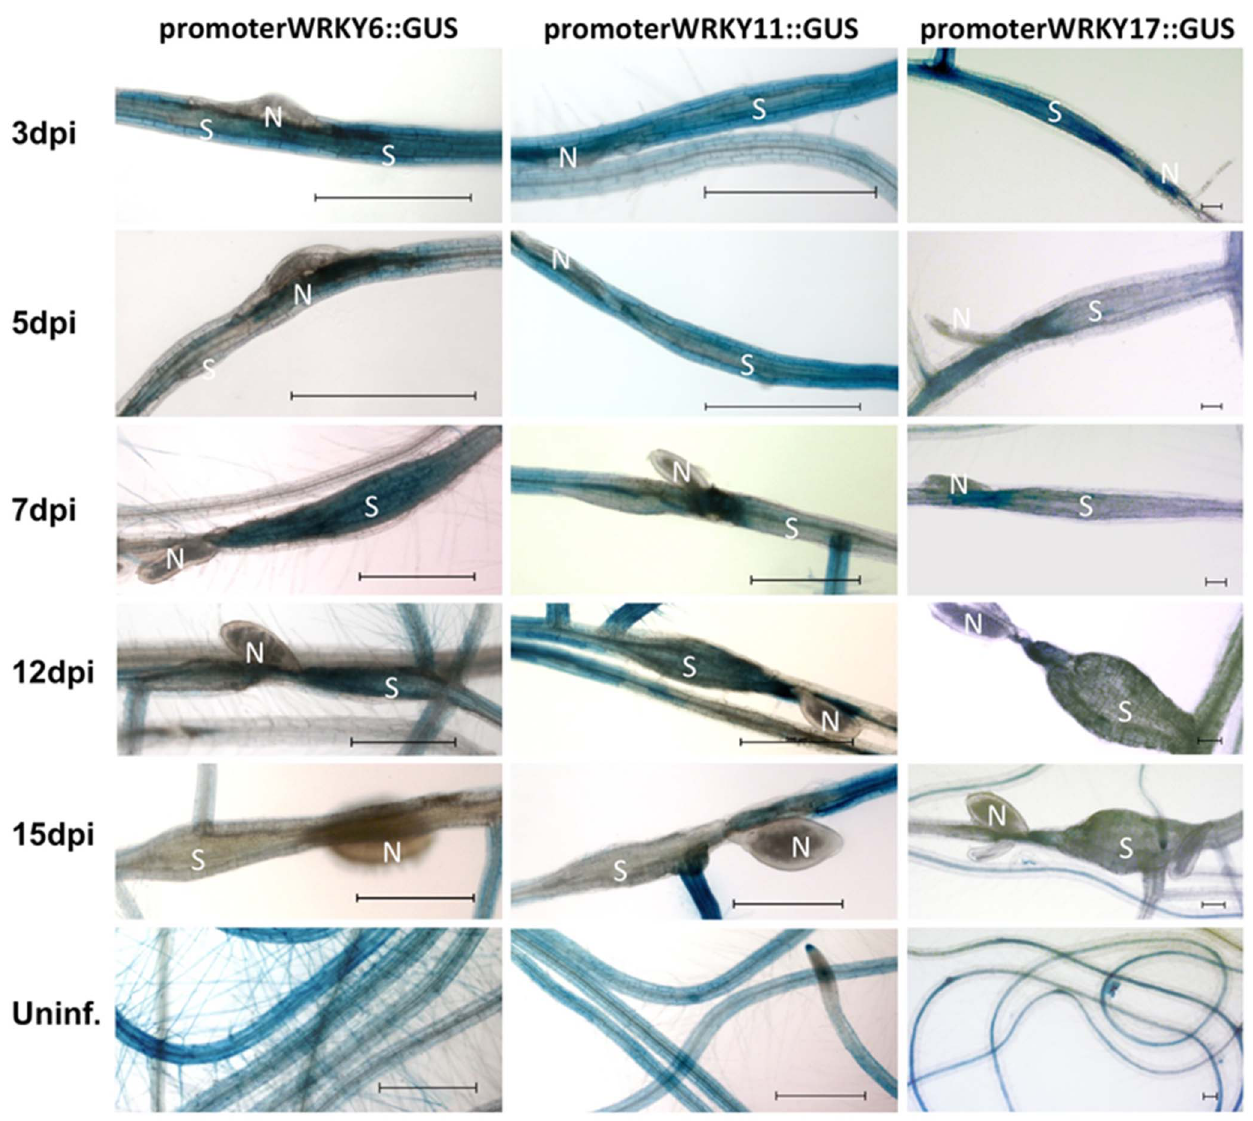
Figure 1. GUS expression of WRKY6 , WRKY11 and WRKY17 in syncytia. GUS staining of promoter::GUS lines for WRKY6 , WRKY11 and WRKY17 was performed for 3, 5, 7, 12, and 15 dpi syncytia and uninfected roots. N=nematode, S=syncytia and bar=500 m m in case of WRKY6 and WRKY11 and bar=100 m m in case of WRKY17 .